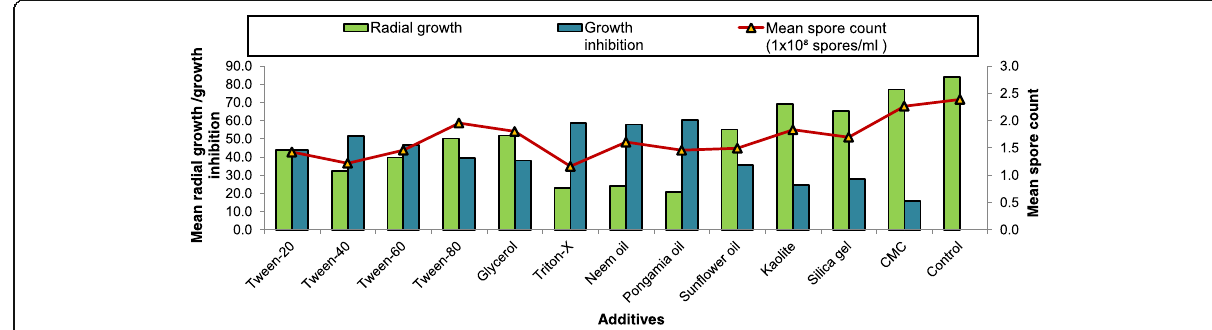
Fig. 1 Mean growth rate (mm), growth inhibition (%), and spore load of B. bassiana on various additives on the 10th day after